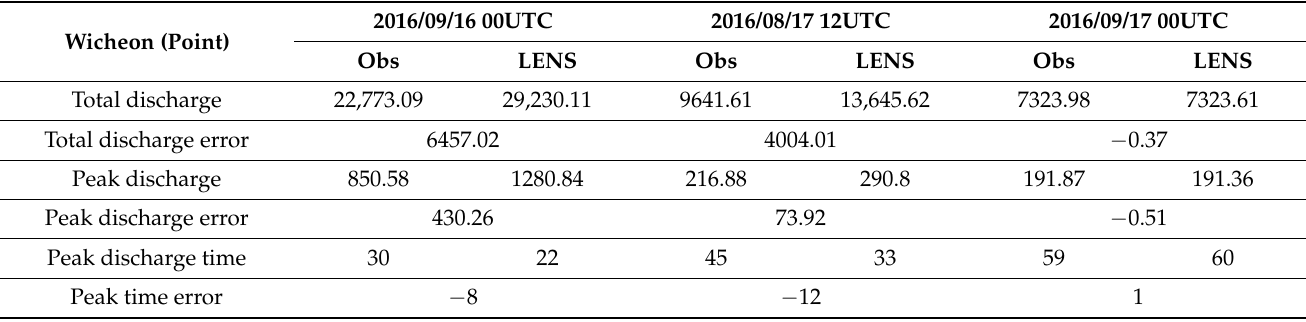
Table 14. LENS point discharge data results from 2016/09/16 00UTC to 2016/09/17 00UTC.